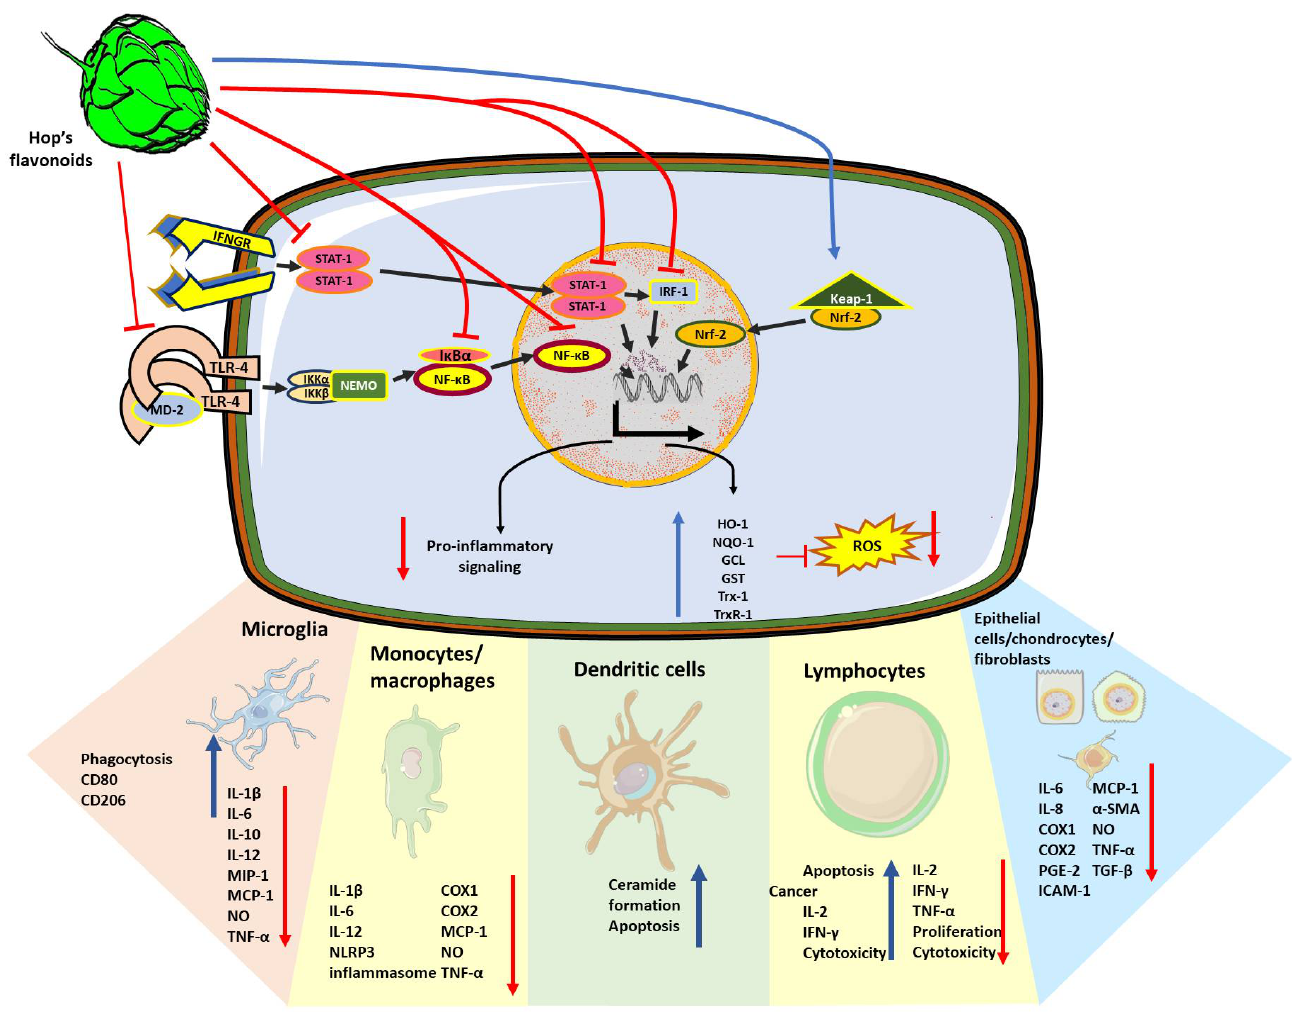
Figure 2. Cellular mechanisms of the anti-inflammatory, immunomodulatory and antioxidant effects exerted by hop compounds. Polyphenols extracted from H. lupulus such as xanthohumol, isoxanthohumol and bitter acids can interfere with intracellular immune signaling pathways at different levels. Due to the inhibition of TLR4 activation through preventing the association of TLR4 dimers with the co-stimulatory molecule MD2, NF-κB nuclear translocation was prevented. Hop compounds inhibit NF-κB signaling pathway due to both, the inhibition of TLR4 activation through preventing the association of TLR4 dimers with the co-stimulatory molecule MD2, and in a TLR-independent fashion. Hop compounds can inhibit other pro-inflammatory signaling pathways driven by STAT-1 and IRF-1. Thus, reducing the expression of the subset of pro-inflammatory mediators such as IL-1β, IL-6, IL-8, IL-10, IL-12, TNF-α, inflammasome subunits, nitric oxide, cyclooxygenases, and prostaglandin production, adhesion molecules such as ICAM-1, MCP-1, and MIP-1. Simultaneously, hop compounds promote microglial phagocytic activity together with the switching to M2 phenotype. In different cell types, hop compounds also prevent fibrotic processes by reducing the expression of α-SMA or TGF-β. However, hop compounds also promote the pro-inflammatory and cytotoxic responses from lymphocytes to elicit anti-tumor responses. Finally, in many cases, the anti-inflammatory effects of hop compounds are accompanied by the activation of the antioxidant response regulator, Nrf-2, and the increase in the production of HO-1, NQO-1, GST, GCL, Trx-1 and TrxR-1.